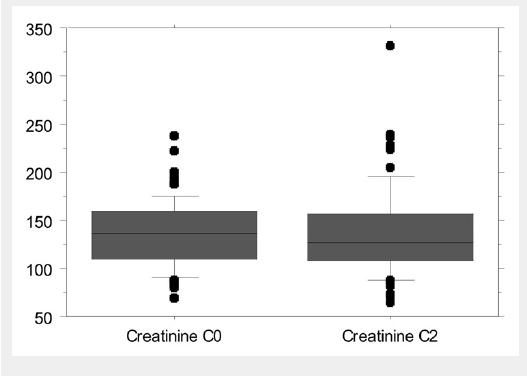
Creatinine levels: 135.4 ± 34.88 µmol/L during C0 monitoring vs. 137.4 ± 47.08 µmol/L during C2 monitoring (p = 0.521).